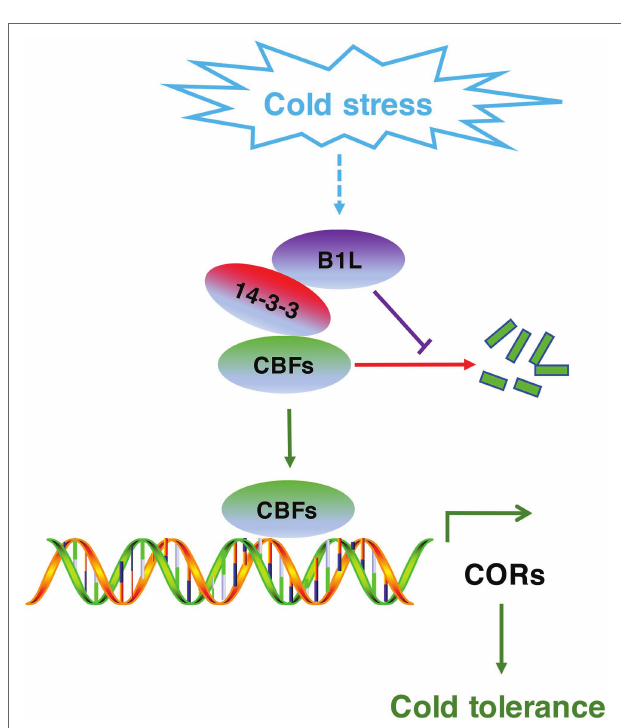
FIGURE 9 | Model for the regulation of the CBF signaling pathway by B1L under cold stress. The expression of B1L is induced by cold stress. Then, B1L interacts with 14-3-3 λ to reduce the 14-3-3 λ -mediated degradation of CBFs. As a result, CBFs induce the expression of their target genes such as COR15a , COR47 , and RD29A to enhance plant freezing